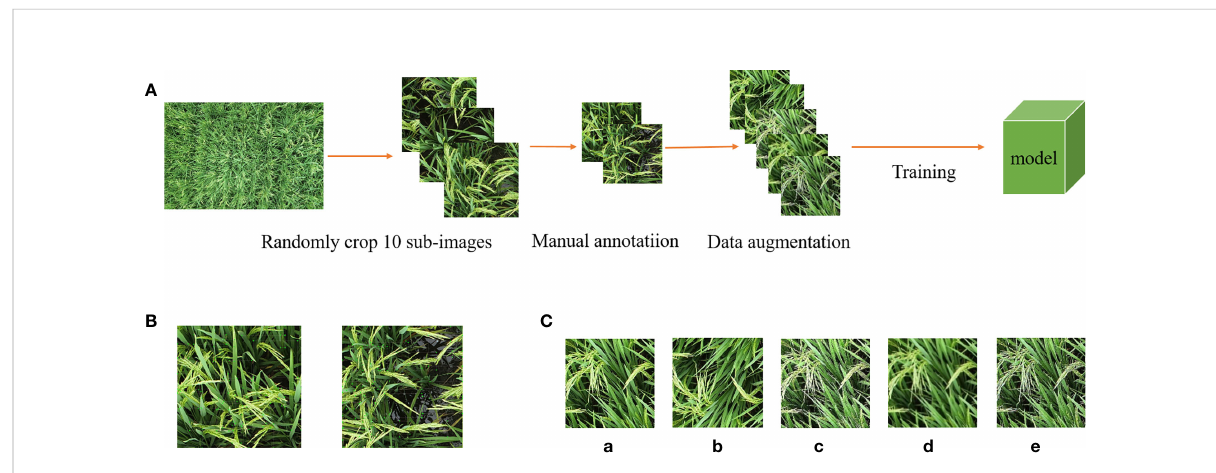
FIGURE 2 Data pre-processing process. (A) Image pre-processing process. (B) Example of data labeling. (C) Panicle image enhancement (a-e) Original image; fl ip up and down; image sharpening; Gaussian noise; e: Emboss fi